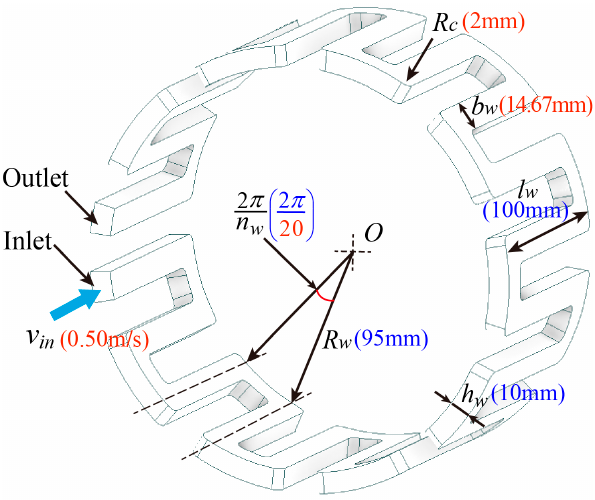
Figure 11. Configuration and main parameters of U-type waterways.